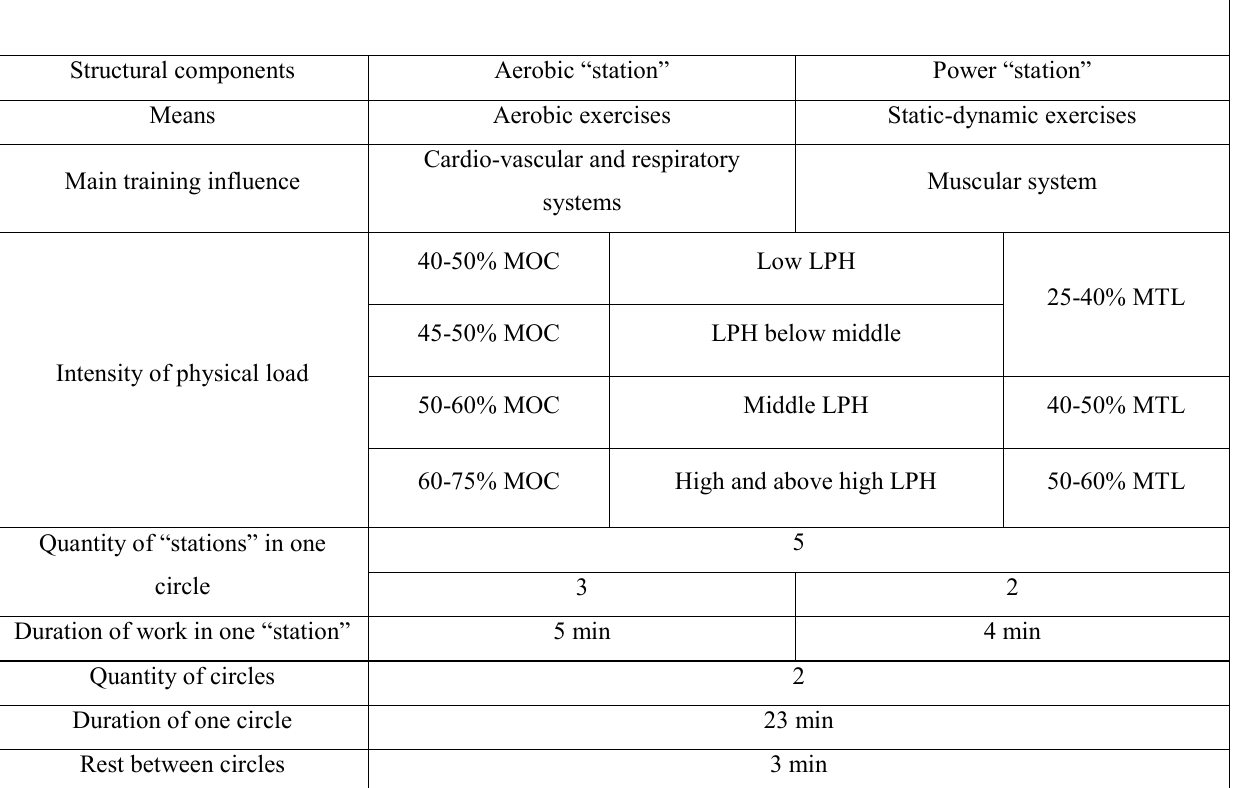
Methodic characteristic of worked out complex of circuit aerobic training of first mature women Circuit training as durable continuous